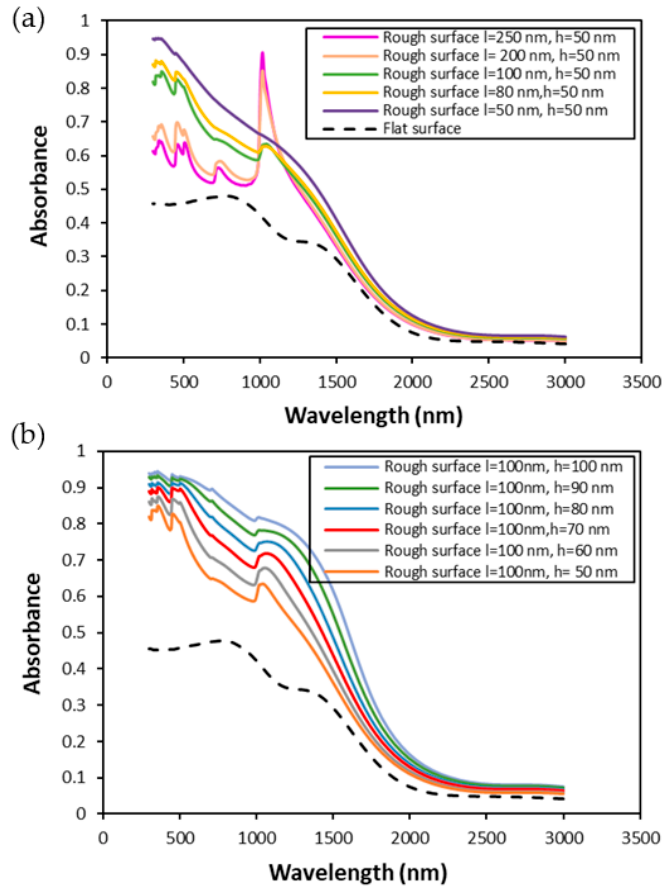
Figure 5. The effect of ( a ) correlation length and ( b ) RMS height in the absorption spectra of an isotropic random rough surface of Tungsten.